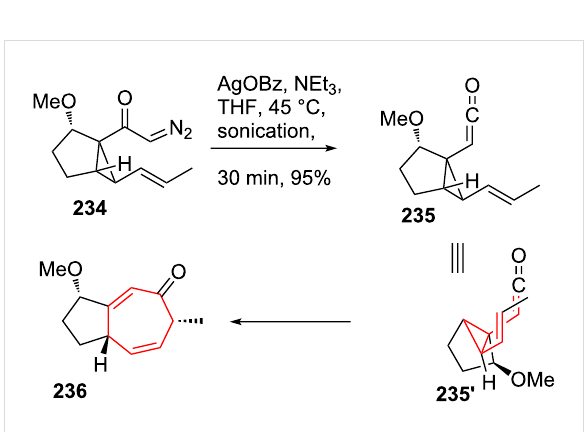
Scheme 28: Stoltz’s tandem Wolff/DVCPR